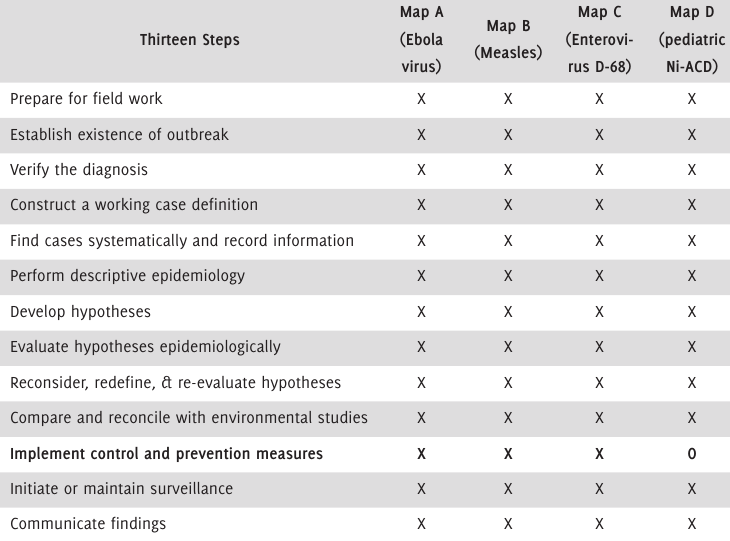
Table 1. Thirteen Steps of Outbreak Investigation with Four Current United States